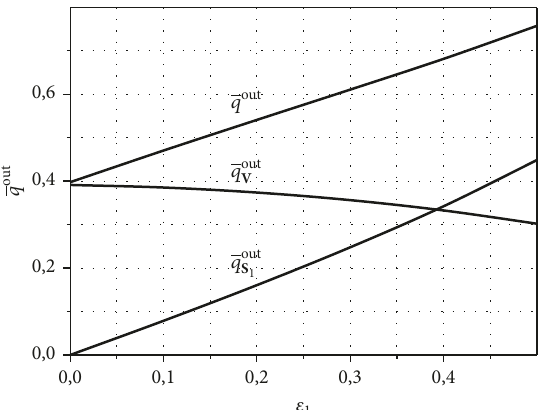
Figure 4: Dependencies of the dimensionless energy flux 𝑞 out